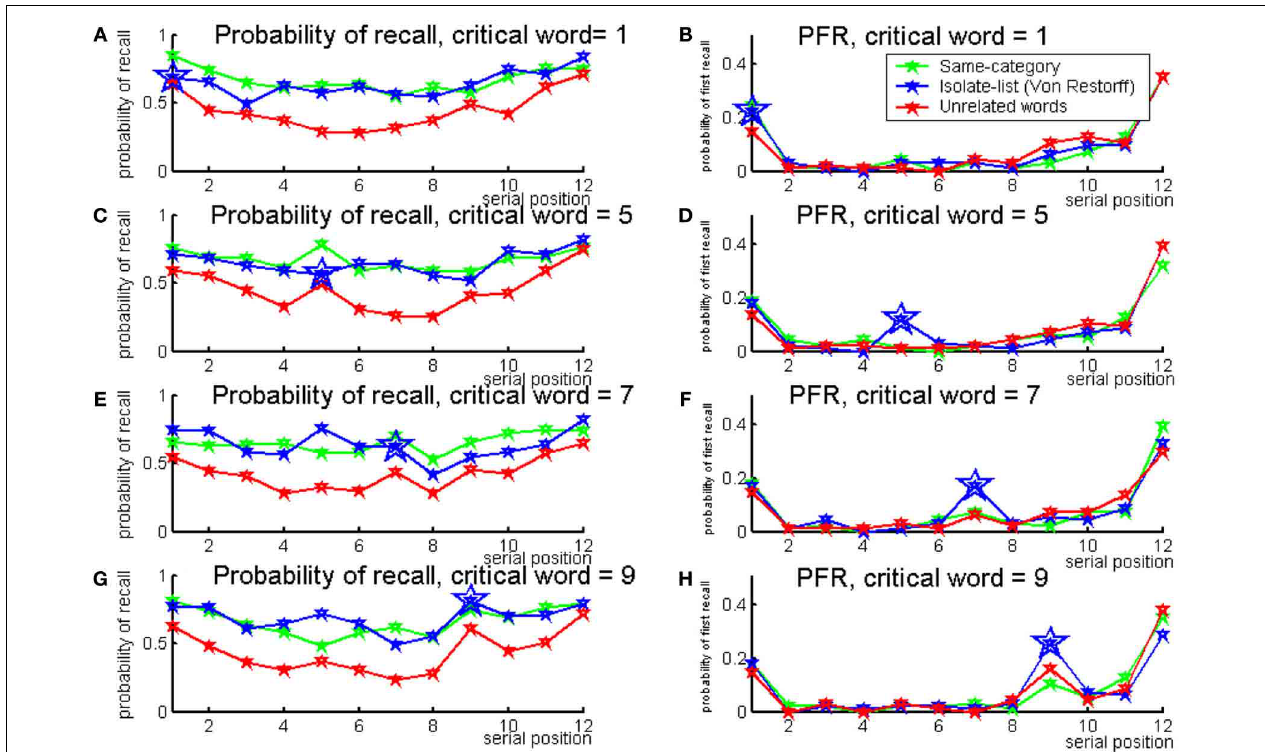
FIGURE 12 | Probability of recall (right) and probability of first recall (left) for lists with critical words at positions: 1 (top), 5 (2nd row), 7 (3rd row), and 9 (bottom). In all panels, same-category